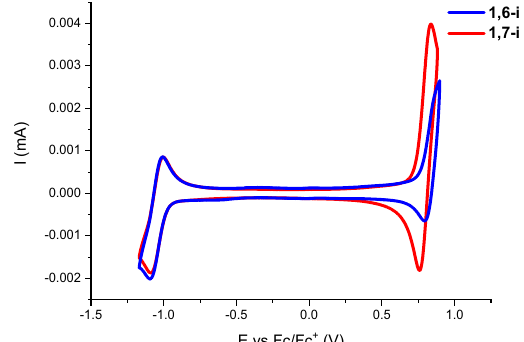
Figure 5. Cyclic voltammograms of 1,7-i (red) and 1,6-i (blue) at a concentration of 0.5 mM in 0.10 M Bu